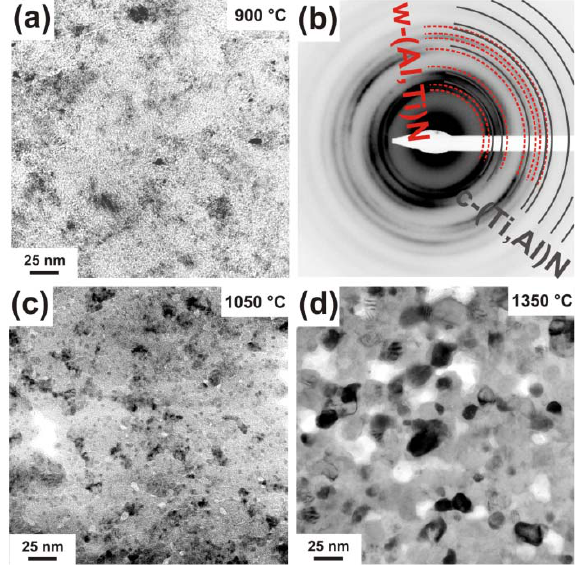
Al Y N 0.46 0.52 0.02